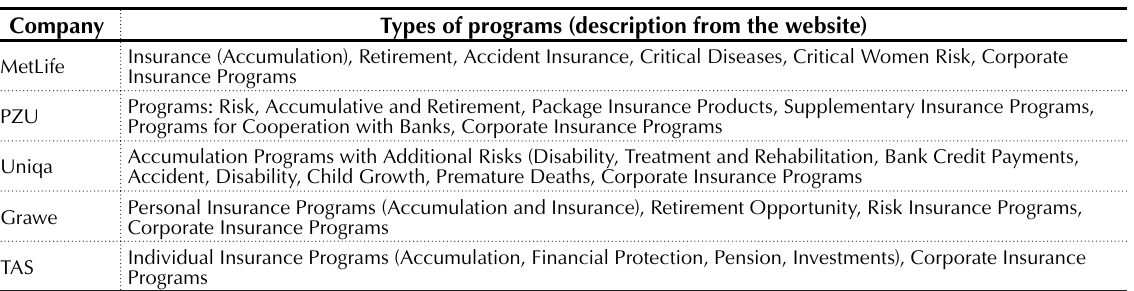
Source: Sites of the companies.